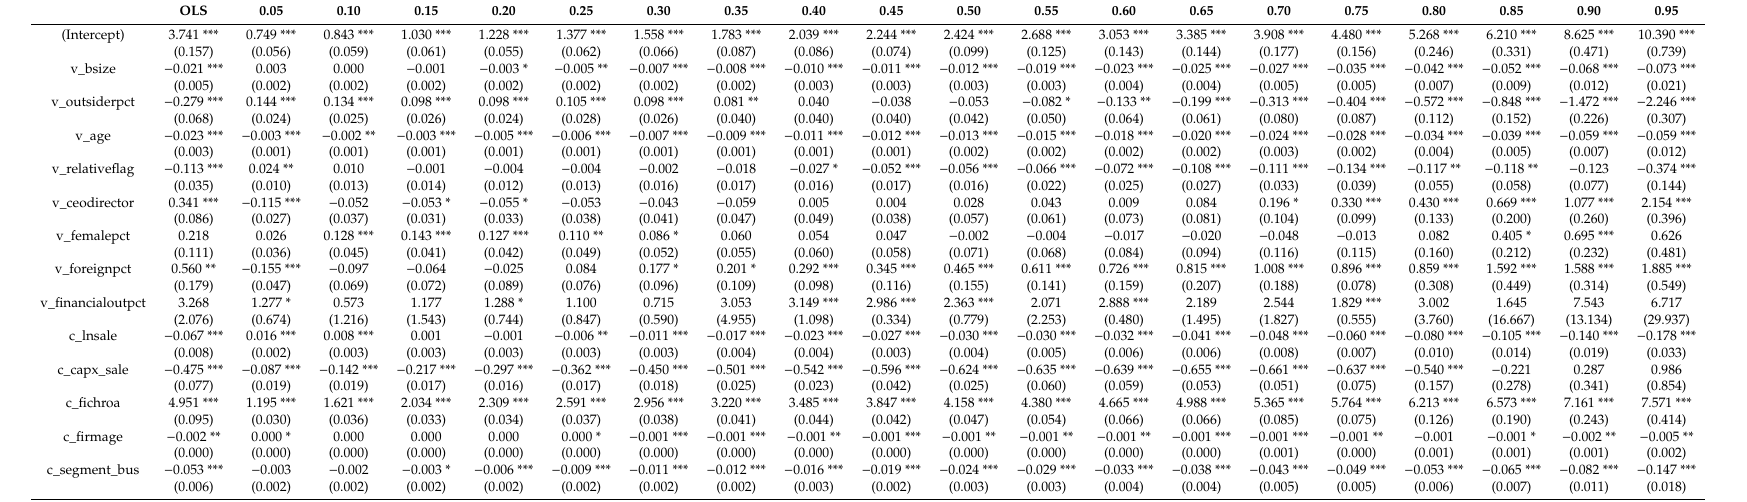
Table 3. The summary statistics of OLS and Quantile regression